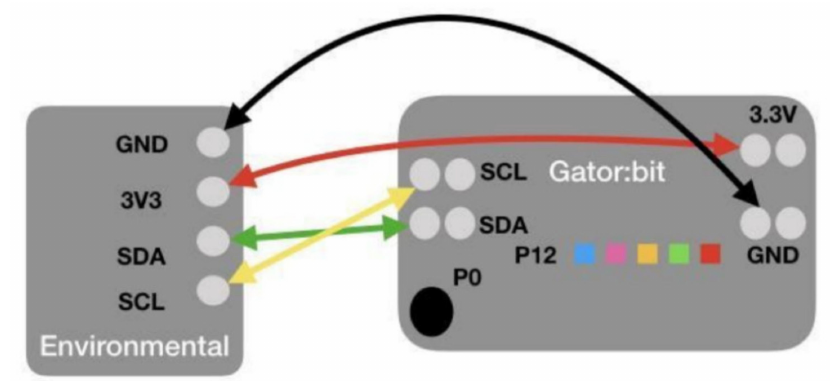
Figure 6. Wiring diagram for the environmental sensor.